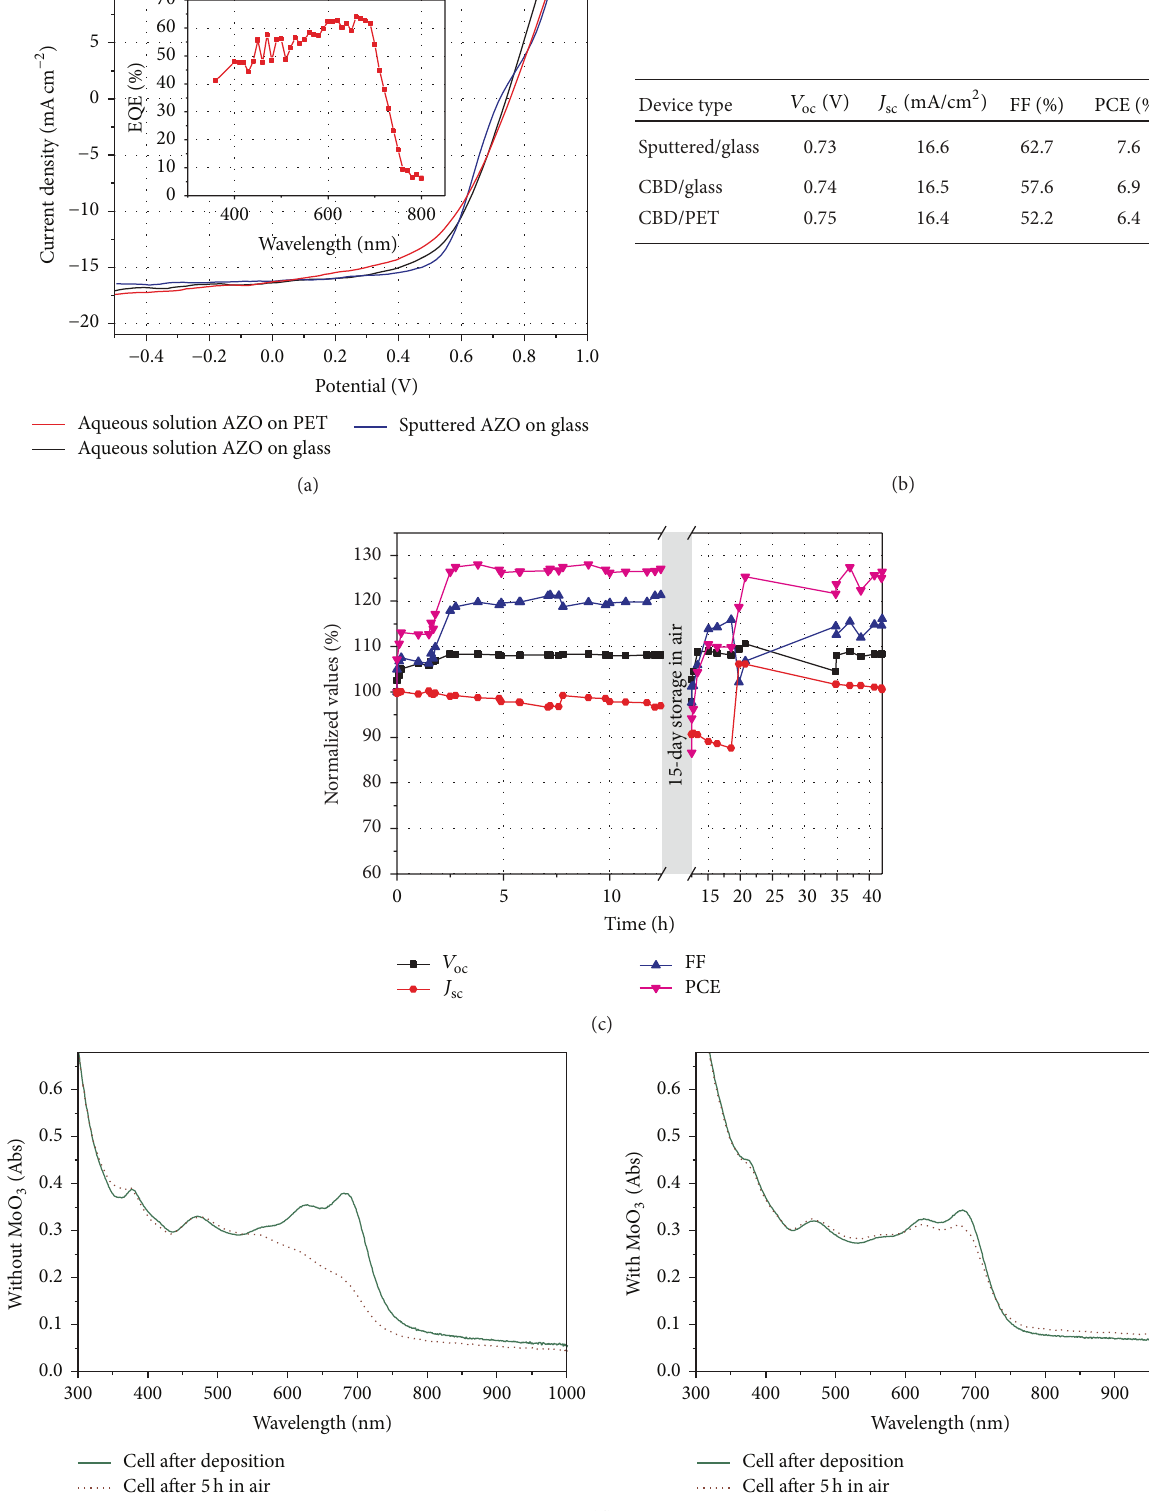
Figure 3: (a) Current-voltage curves for the best devices with AZO sputtered on glass, solution deposited AZO on glass, and solution- processed AZO on PET foil. Inset: external quantum efficiency (EQE) for a cell on PET foil. (b) Photovoltaic parameters for the curves in (a). (c) Stability under AM1.5 irradiation in air. (d) Normal incidence absorbance spectra of the active layer with and without a MoO 3 (15nm) top layer before (solid curves) and after 5-hour irradiation in air (dotted curves). The interference fringes are due to the AZO